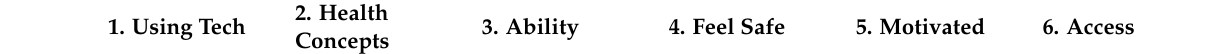
Table A1. Pearson correlations of the seven eHLQ scales.